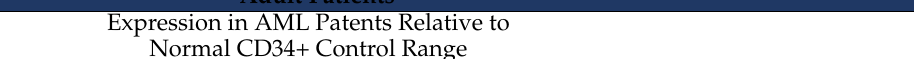
Table 1. DDR protein expression and activation are abnormal in adult and pediatric